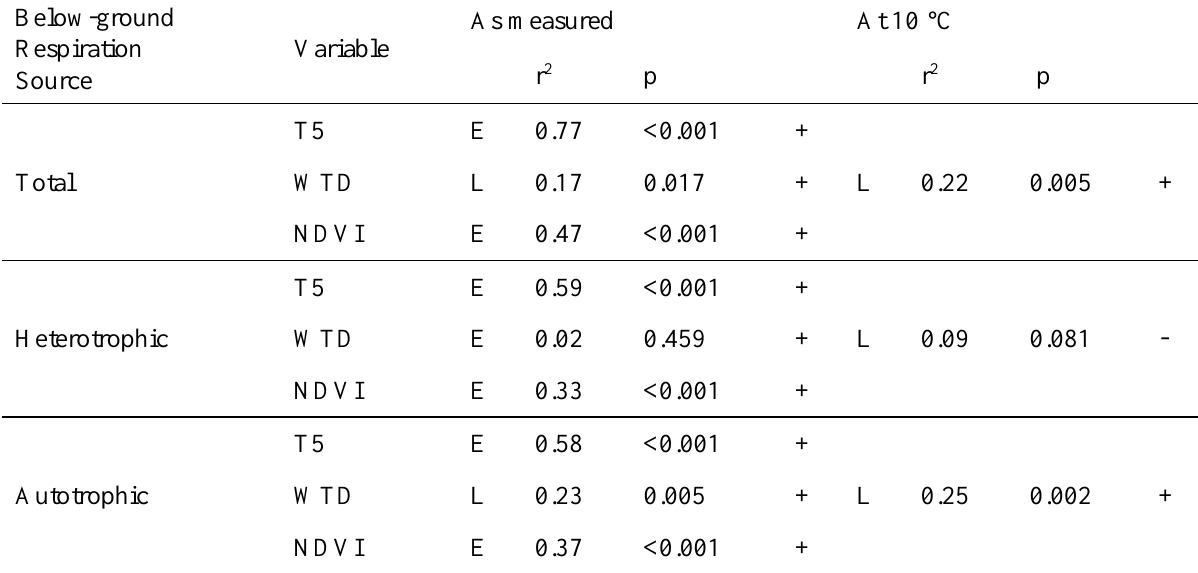
Table 2. Relationships between below-ground respiration and temporal variables. Regression coefficient (r 2 ) and significance (p) of exponential (E) or linear (L) relationships between total below-ground, heterotrophic below-ground and autotrophic below-ground respiration as measured and corrected to 10 °C and soil temperature at 5 cm (°C) (T5), water table depth (cm below surface) (WTD) and normalised difference vegetation index (NDVI). + indicates a positive relationship, – a negative